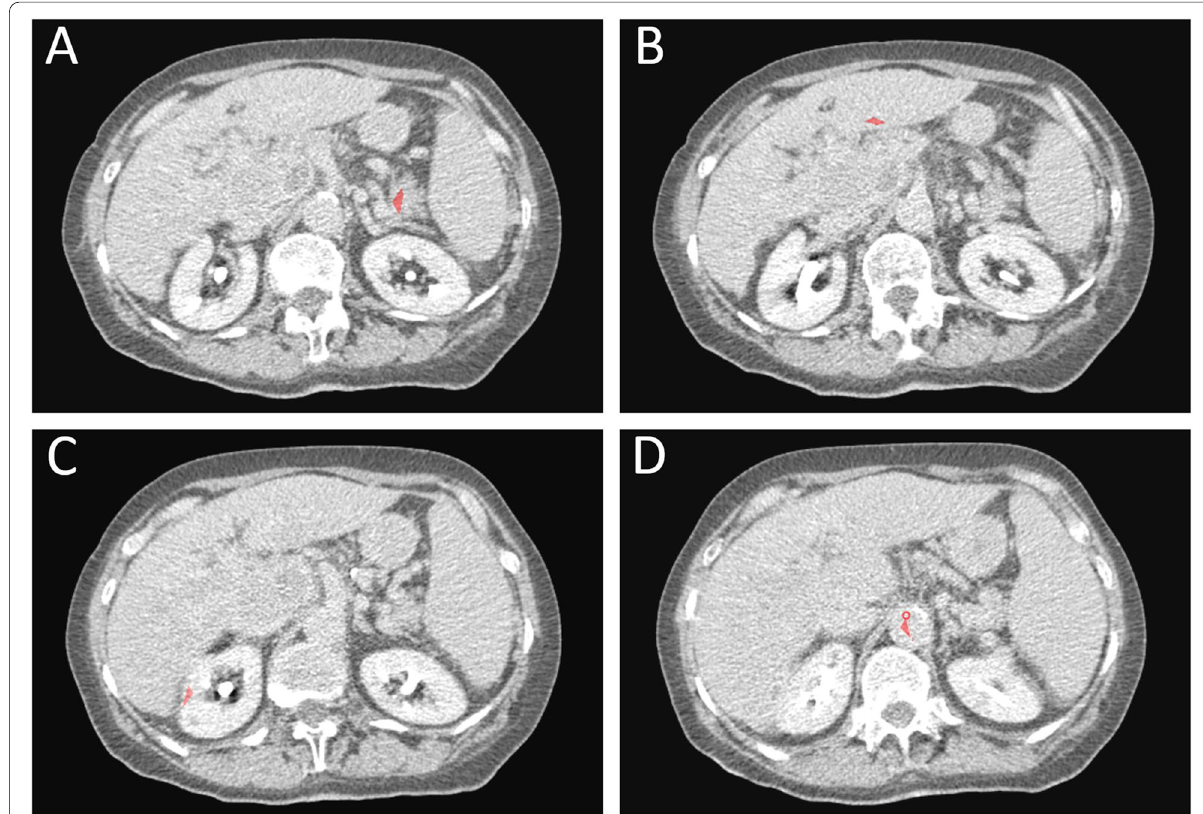
Fig. 1 ROIs drawn to compute the time-enhancement curves. In A , a ROI on the pancreas was drawn on the largest pancreatic portion included in the CT study volume. While this portion is usually represented by the pancreatic head, in this case the pancreatic head was not included in the study volume due to a pathologic lymph node and the ROI was drawn on the pancreatic tail. B ROI drawn on an HCC focus. C ROI drawn on the cortex of the right kidney. D ROI drawn in the aorta, between the emergency of the superior mesenteric artery and of the renal